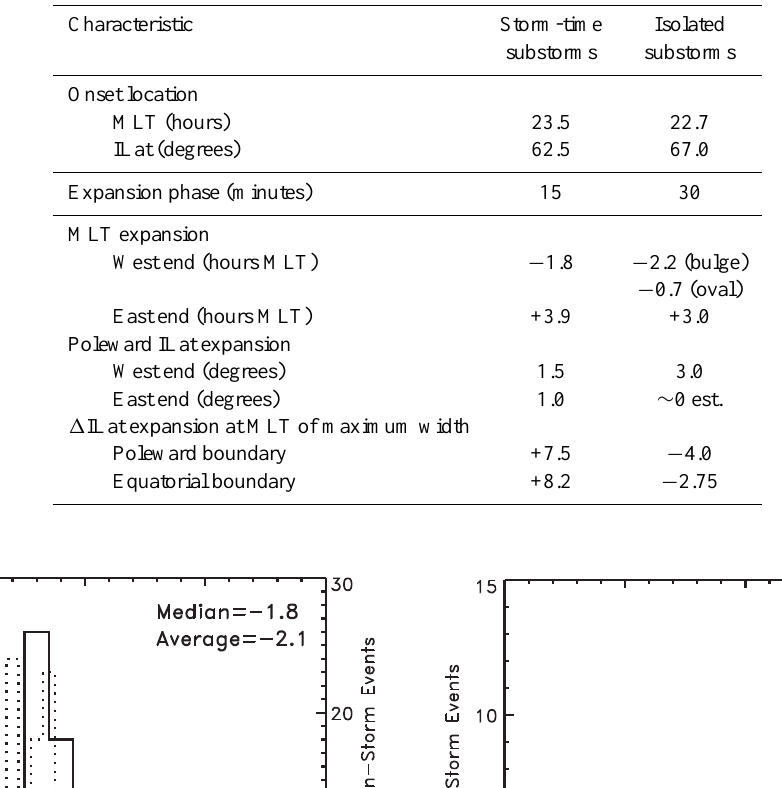
Table 2. Median parameters comparing substorms during main phase development with isolated substorms.